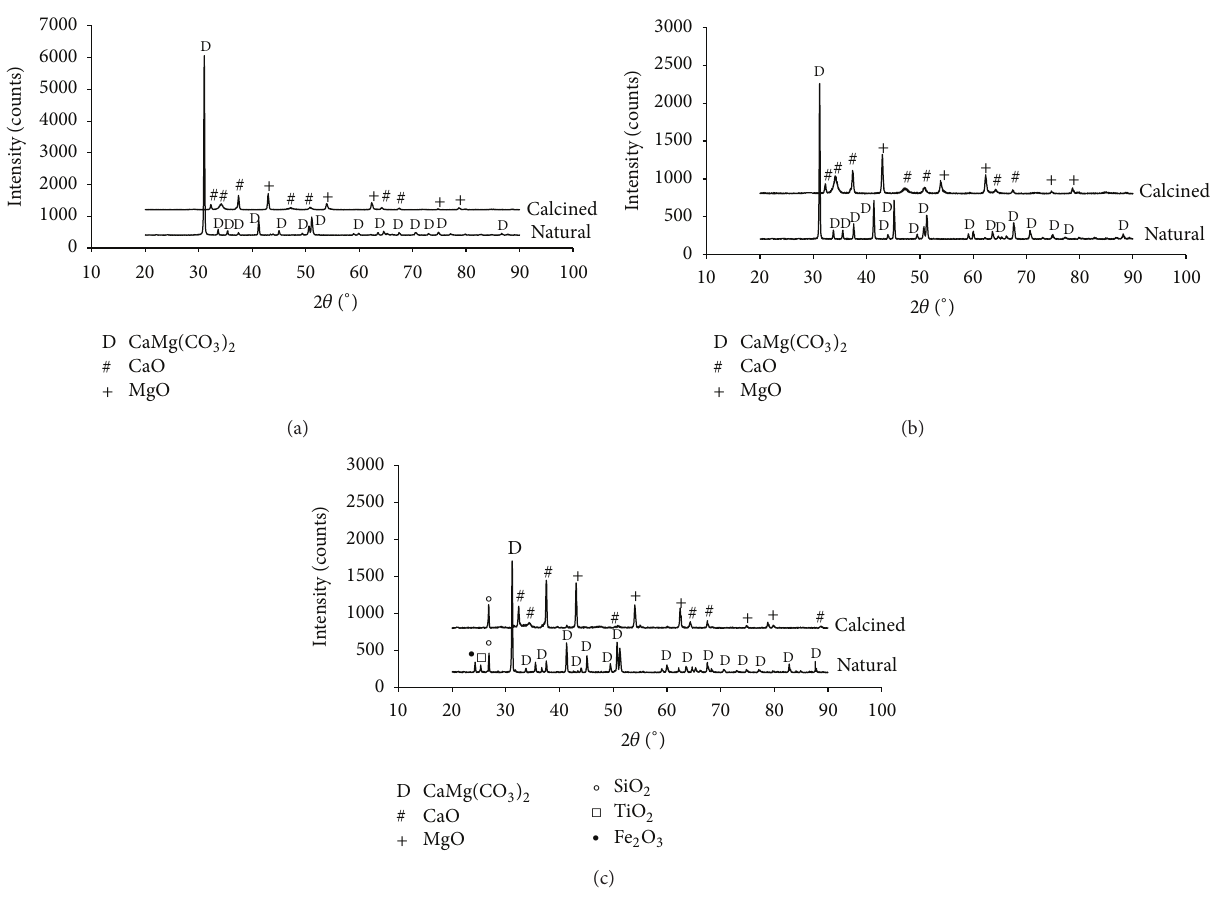
Figure 3: XRD analysis before and after calcination (a) P1 dolomite, (b) P2 dolomite, and (c) P3 dolomite.